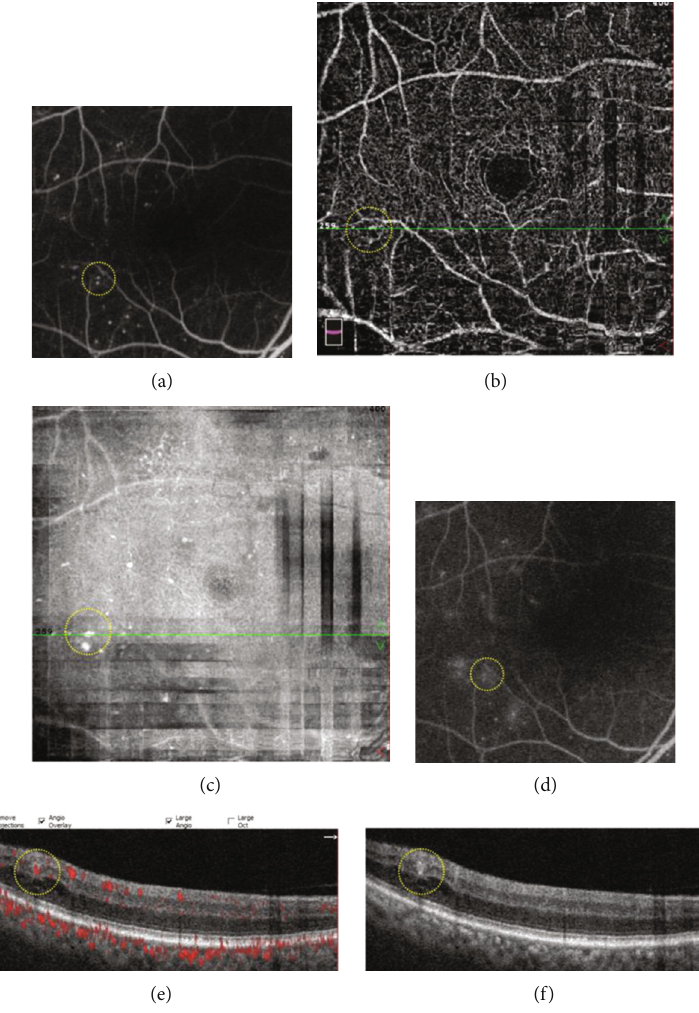
Figure 4: A typical diabetic microaneurysm with severe leakage on FA (yellow circle (a), early phase of FA (d), late phase of FA). The microaneurysm was visualized as nodular type in OCTA en face image (yellow circle (b)). On OCT en face image, the microaneurysm appeared as a luminescent spot (yellow circle (c)). The microaneurysm was recognized a thin-walled oval lesion on OCT B-scan with a retinal cyst nearby (yellow circle (f)), and the fl ow proportion of the microaneurysm was 57.8% on OCT B-scan with fl ow overlay (yellow circle (e)). Table 1: Demographics of